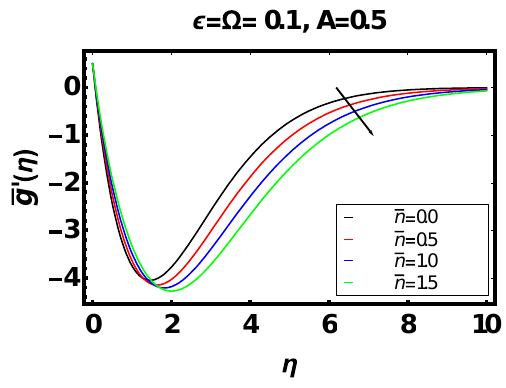
Figure 5. Velocity along y -direction for variant n .